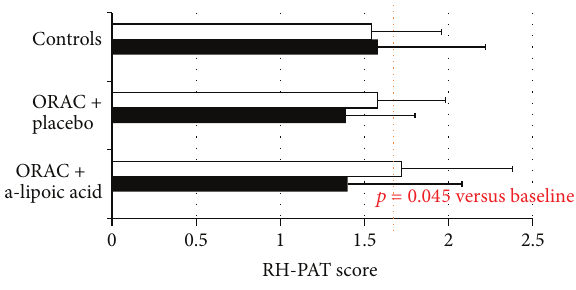
Figure 1: Endothelial function as RH-PAT score at baseline ( ◼ ) and after 6-month follow-up ( ◻ ); dotted line represents the normal value for the